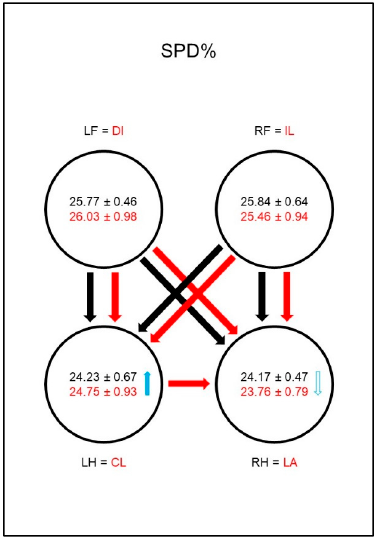
Figure 5. Stance phase duration as a percentage of total stance phase duration (SPD%) in study group 1 and control group. For detailed explanation and abbreviations refer to Figure 2.